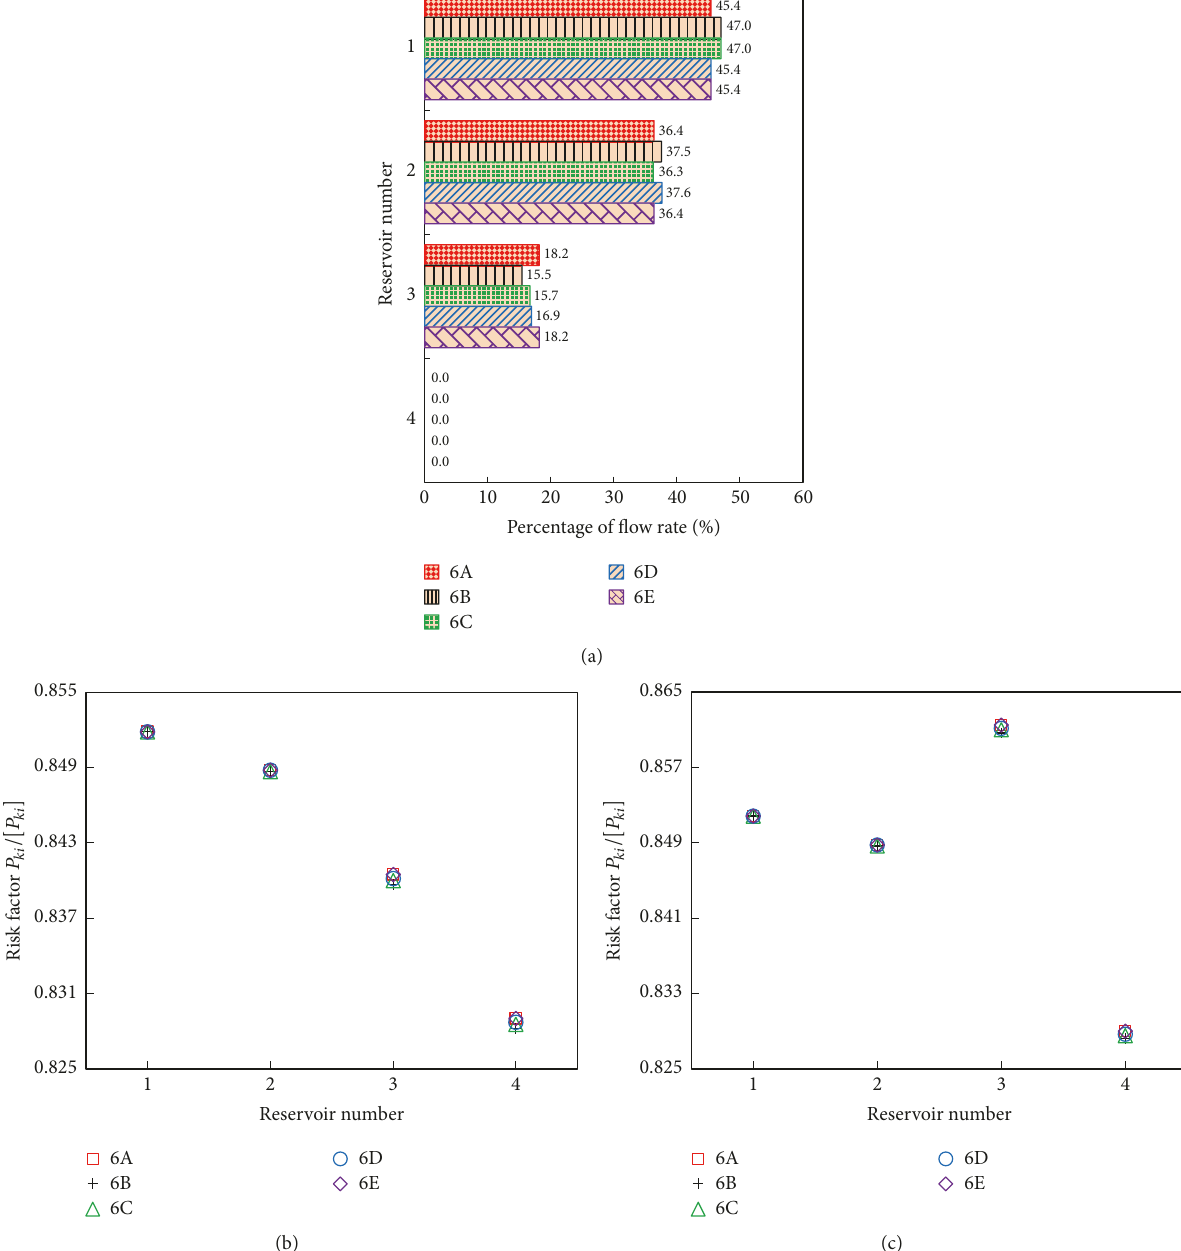
Figure 10: Proportions of the inflows (a) and risk factors of each reservoir for different reservoir porosities for the two scenarios of the conceptual engineering model. (b) and (c) are the risk-factor results for Scenarios S-1 and S-2, respectively.